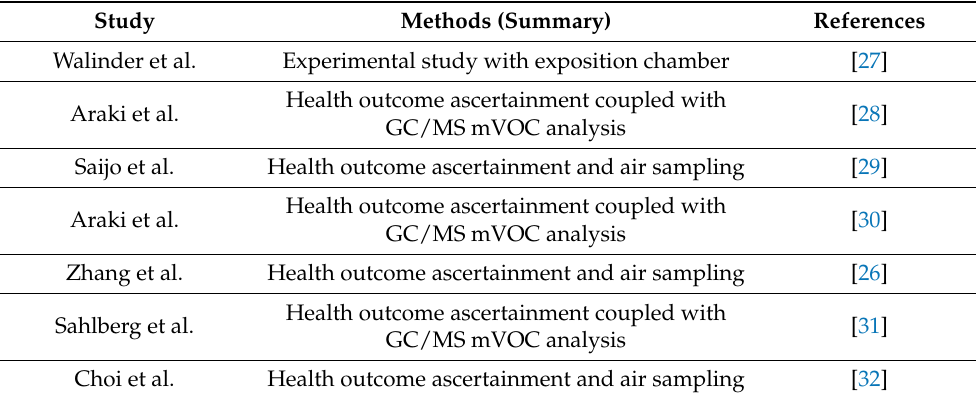
Table 1. Overview of studies regarding respiratory-health related symptoms with microbial volatile organic